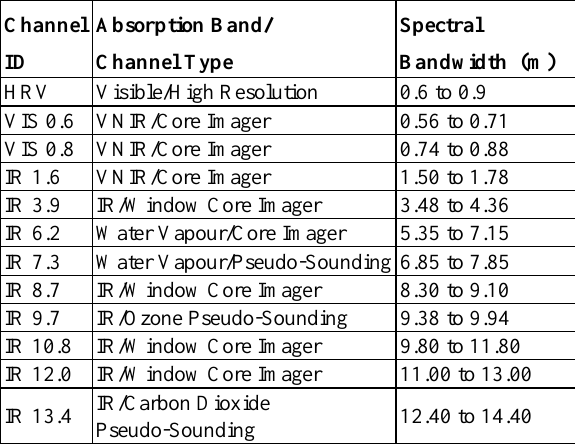
Table 1. SEVIRI band characteristics (EUMETSAT,